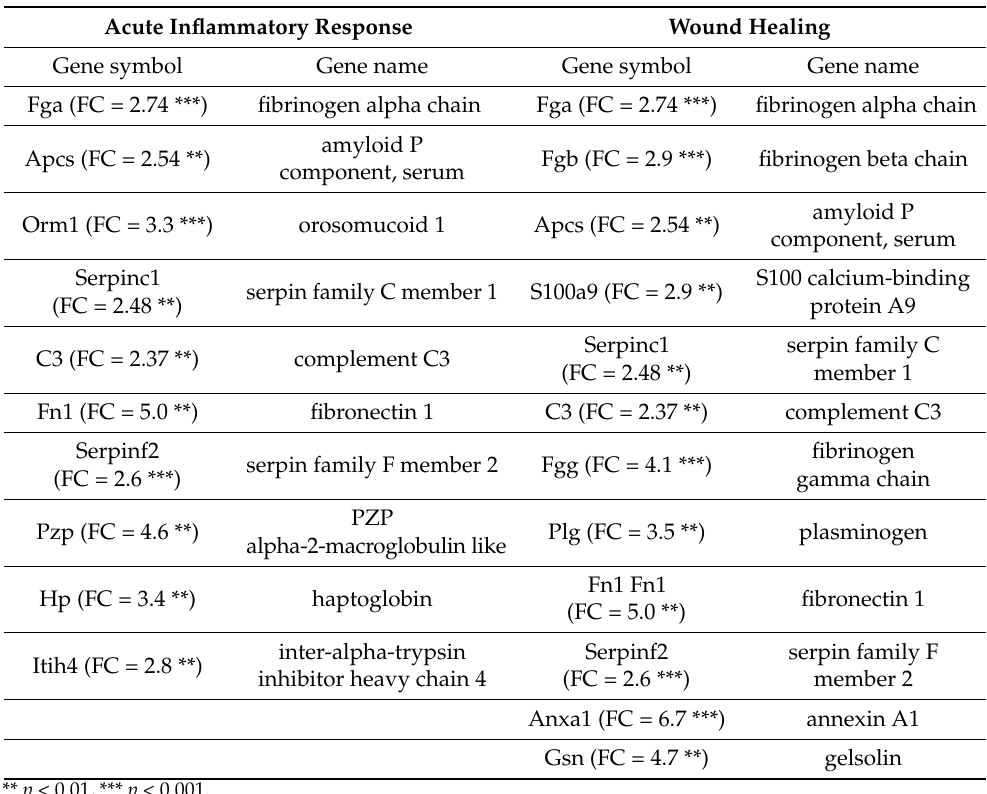
Table 3. Proteins identified from functional enrichment (ToppFun) analysis of upregulated proteins (Table S2) in the EV-treated hindlimb related to acute inflammatory response and wound healing. Fold-change (FC) and p -values are shown for each gene.